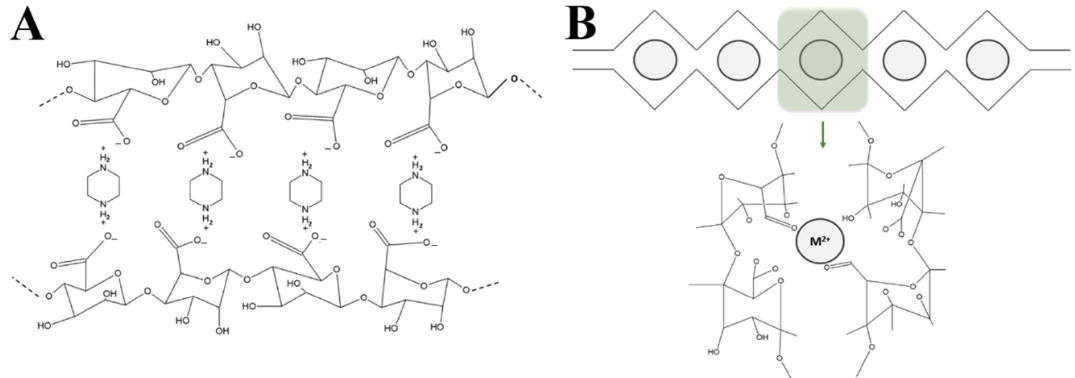
Figure 3. ( A ) Schematic representation of interactions between alginate and piperazine to form microparticles; ( B ) schematic representation of the interactions between alginate and divalent ions.